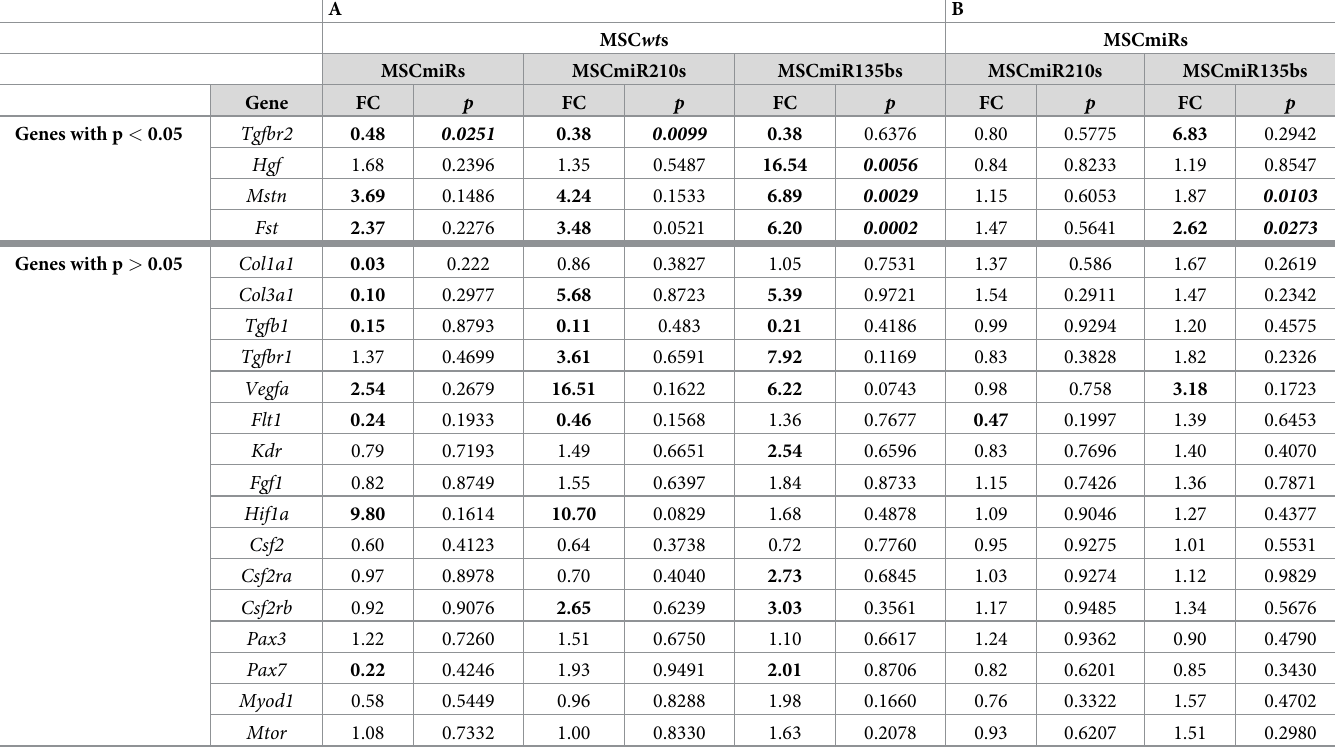
Table 1. Gene expression levels in modified MSCs compared with MSC wt s and MSCmiR control